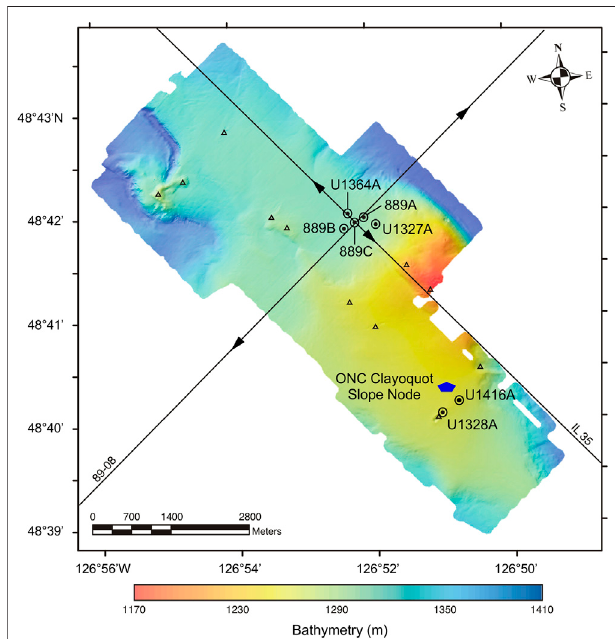
FIGURE 2 | Borehole locations from ODP Leg 146 (889A-C), Expedition 311 (U1327A, U1327B, and U1328A), Expedition 341S (U1416A), and Expedition 328 (U1364A) on multibeam bathymetric data from Paull et al. (2015).Also shownisapproximatepositionoftheONC Clayoquot Slope node. Arrowheads on PGC 89-08 and IL35 seismic lines show approximate extents of sections shown in Figure 3 . Triangles show locations of mapped sea fl oor formation fl uid or gas seeps from Scherwath et al. (2019). Site U1416Aisnotdiscussedinthispaper,butitisshownbecauseitisthelocation of a SCIMPI (Simple Cabled Instrument to Measure Parameters In Situ ) observatory also intended to monitor temperatures down to BSR depths (Expedition 341S Scientists and Engineers, 2013; Lado-Insua et al.,